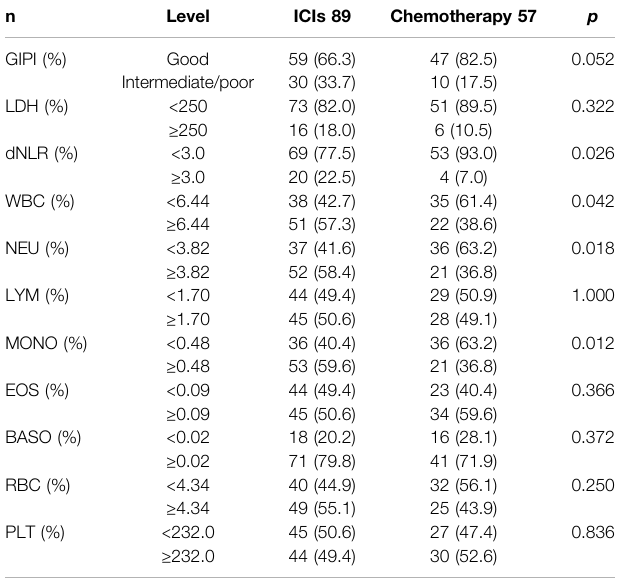
TABLE 5 | The blood parameters for treatment (ICIs and